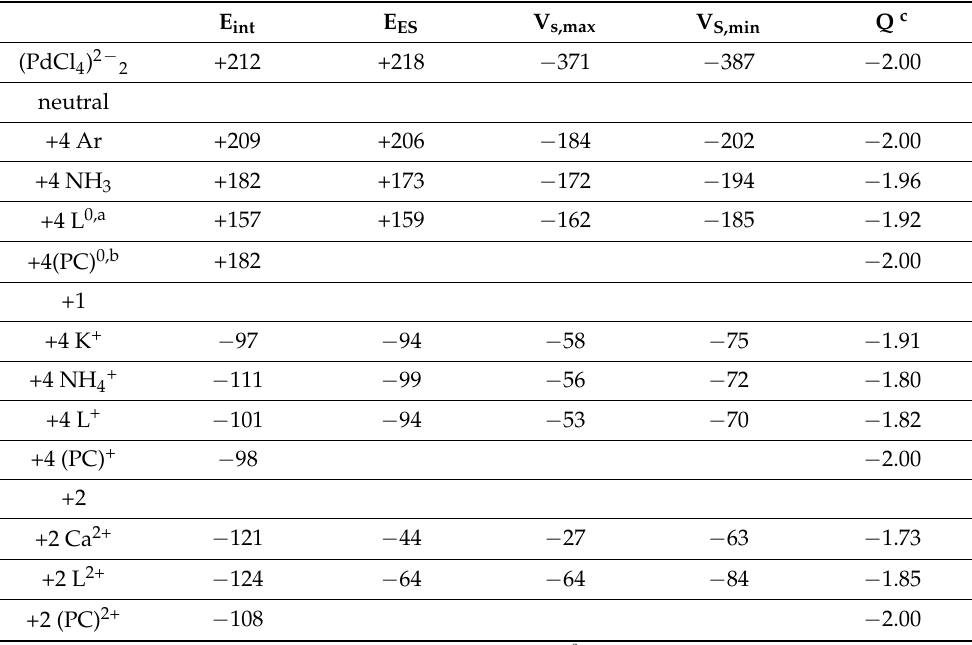
maximum and minimum of the MEP of the uncomplexed subunits (kcal/mol), and total charge (Q, e) assigned to PdCl 4 segment within